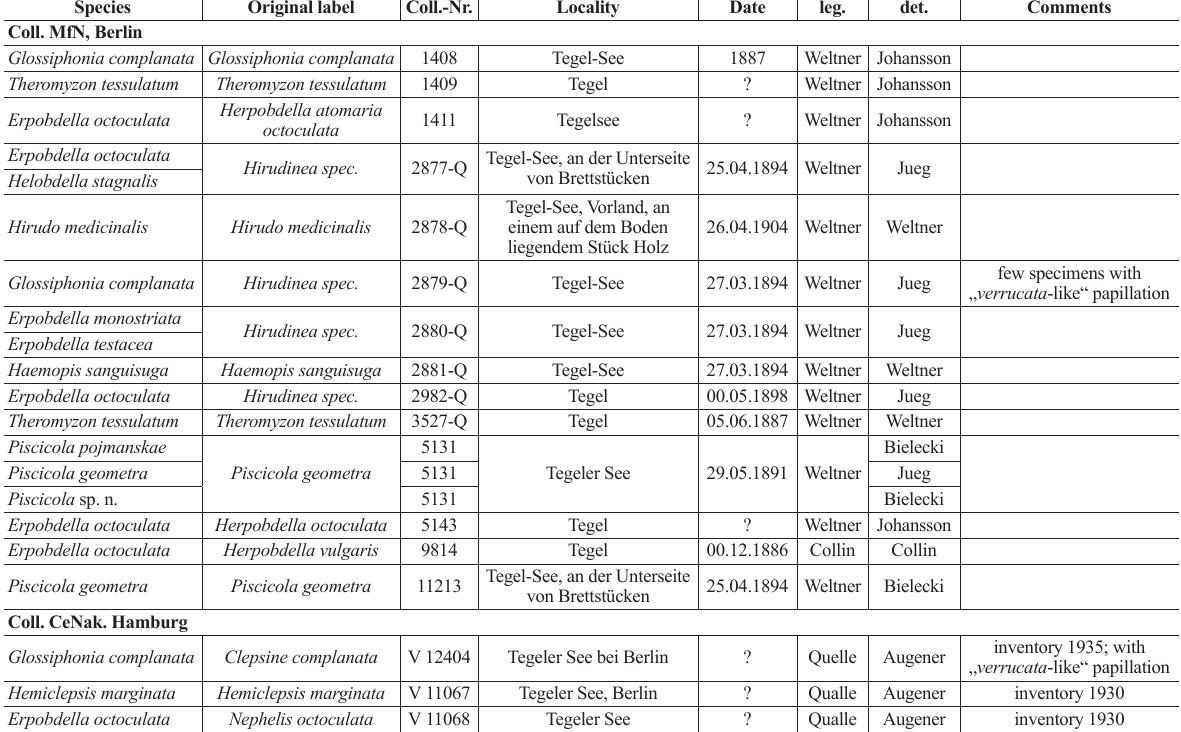
Table 3. Records from Lake Tegel present in the zoological collection of the CeNak Hamburg (revised by Jueg) and the Museum of Natural History in Berlin (MfN, partly determined and revised by